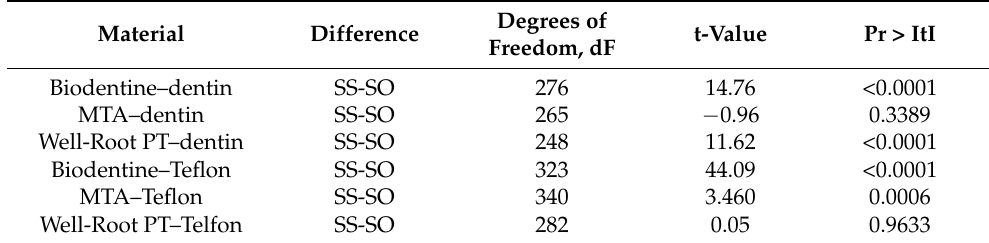
Table 3. Results of paired T-test for differences between two measures zones (SS and SO) for three materials in dentin and Teflon.